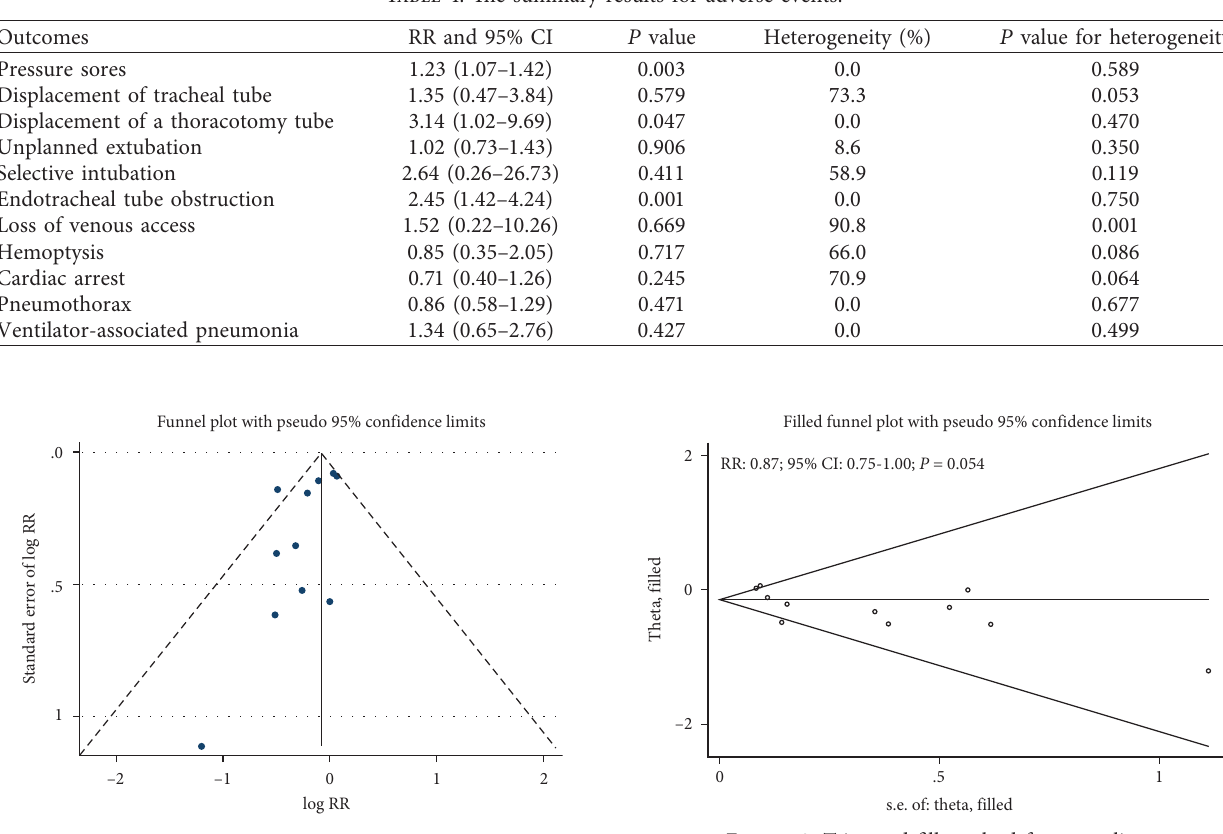
Figure 8: Trim and fill method for